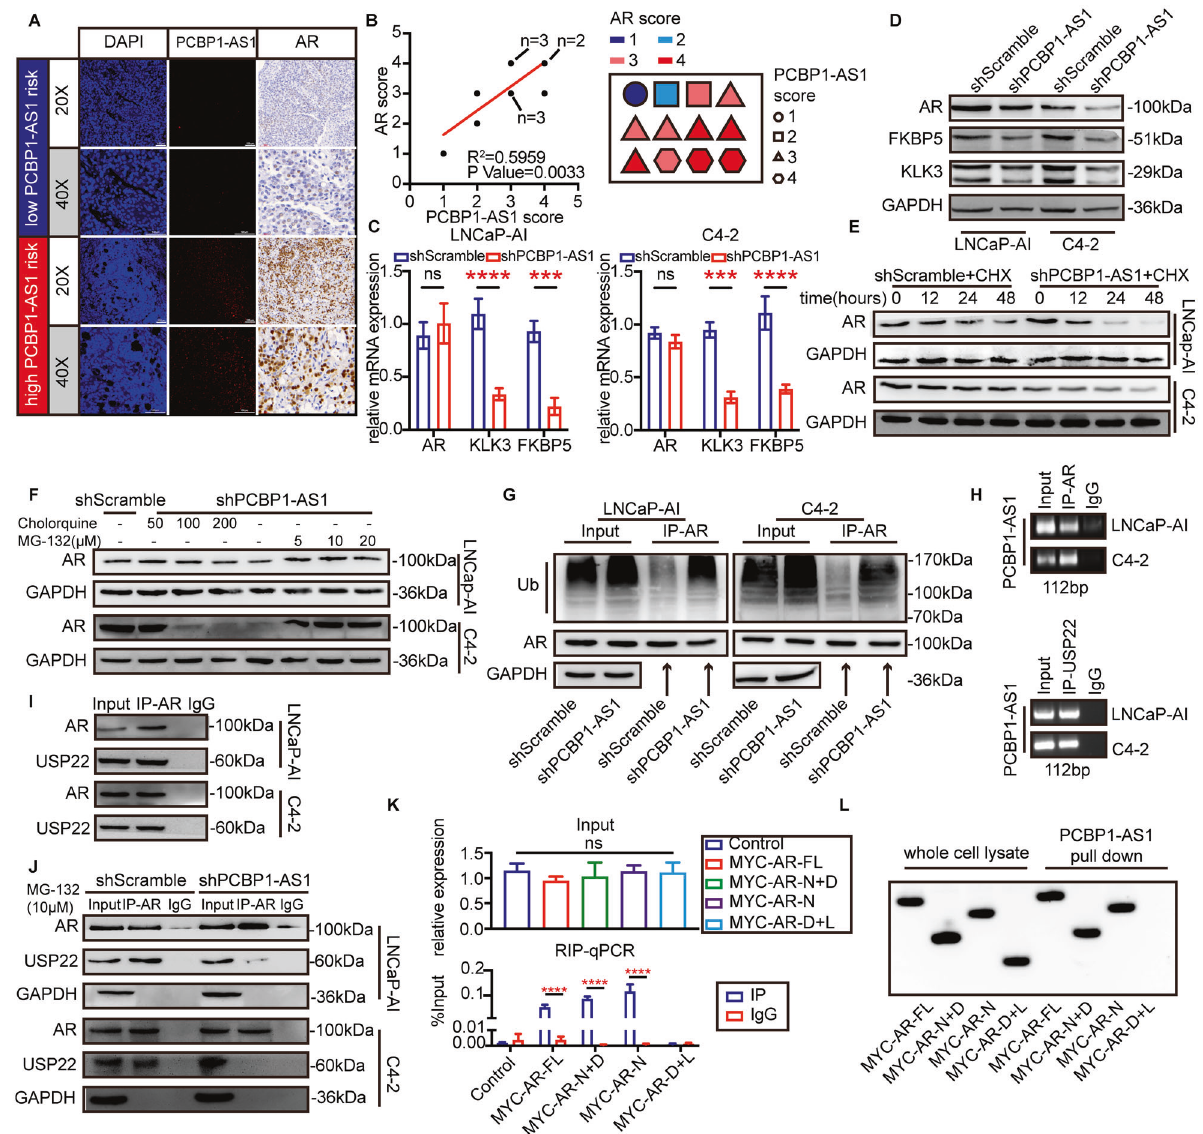
Fig. 3 PCBP1-AS1 promotes USP22-AR stability by binding to AR NTD domain and enhances AR deubiquitination. A comparison of AR IHC and PCBP1-AS1 RNA-scope. All graphs present the same location of the same patients. B Left panel presents the Pearson ’ s correlation value R 2 and P value of PCBP1-AS1 RNA-scope score and AR IHC score. Right panel presents the number, PCBP1-AS1 score, and AR score of each CRPC patient. The score was given by three experimental pathologists. C qPCR showed the expression of AR, KLK3, and FKBP5 RNA expression in LNCaP-AI and C4-2 cells before and after PCBP1-AS1 knockdown. D Western blot presents the expression of AR, KLK3, and FKBP5 protein expression in LNCaP-AI and C4-2 cells before and after PCBP1-AS1 knockdown. E AR protein degradation rate. CHX concentration: 100